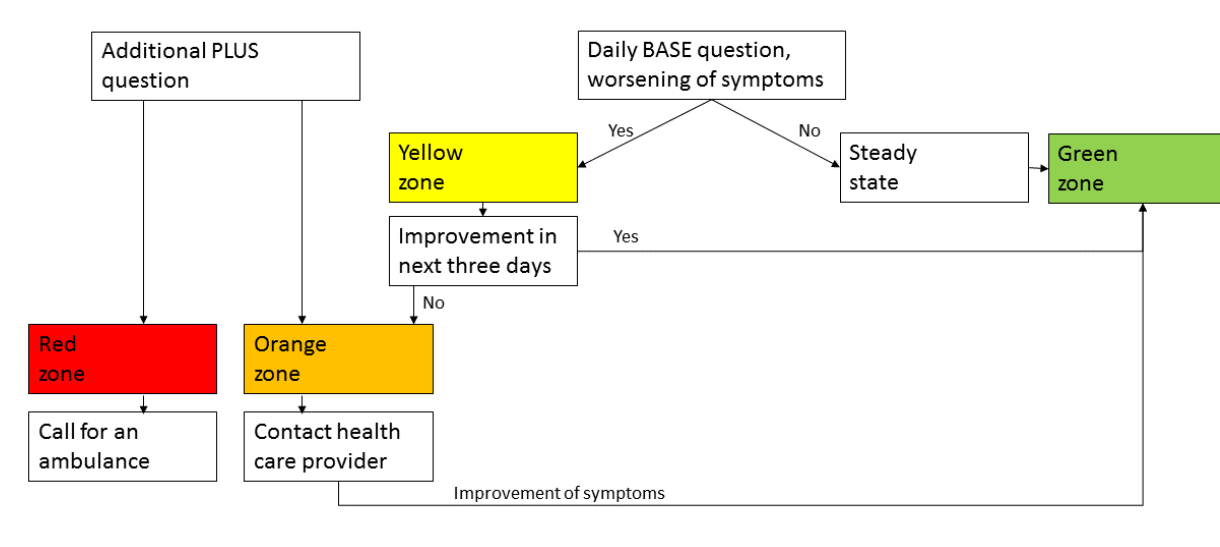
Figure 3. Flow chart with zones, based on